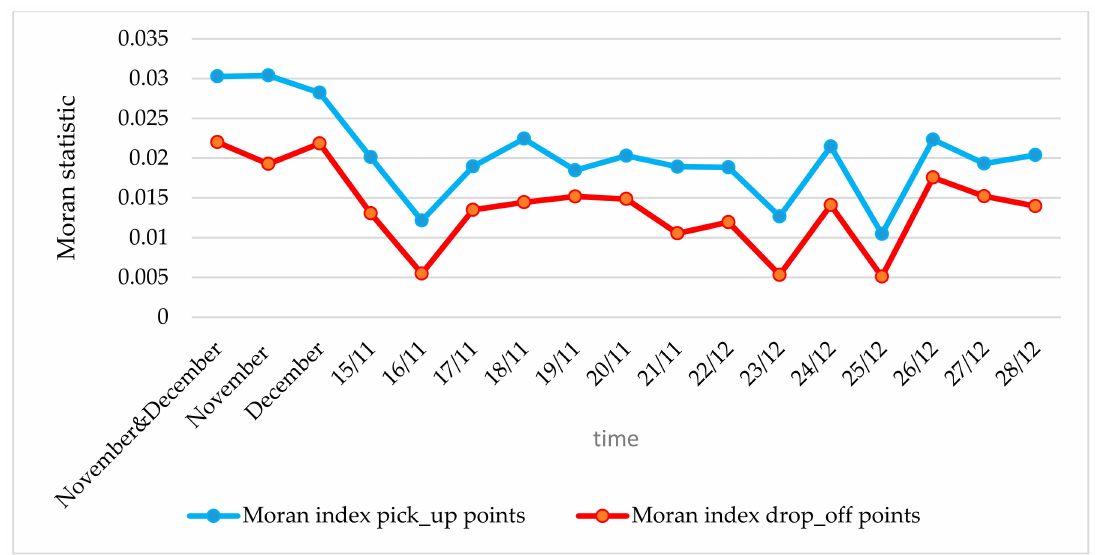
Figure 8. Moran index changes over